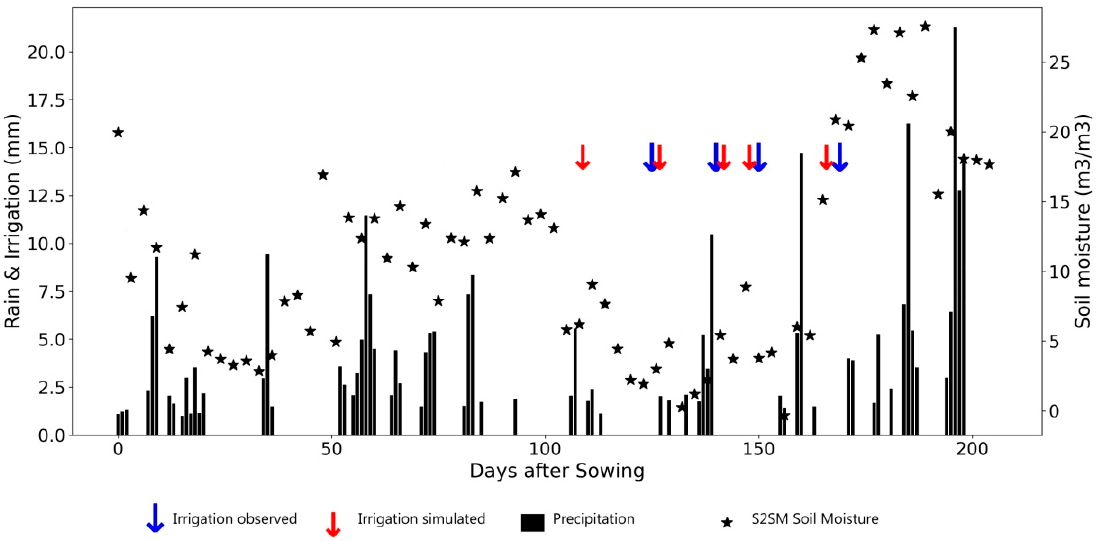
Figure 11. Example of detection events of low frequency and average amounts of irrigation on winter rye in Brandenburg in 2017. Irrigation observations are indicated by blue arrows (Irri_obs); irrigation simulations are indicated by red arrows (Irri_simu). Actual rainfall events are shown with black bars. The interpolated S2SM product (selected every three days) is shown by stars. Vegetation (Kc b ) is shown with blue dashed lines and the model predictions of soil moisture are also shown (SM_FAO, and SM_top).